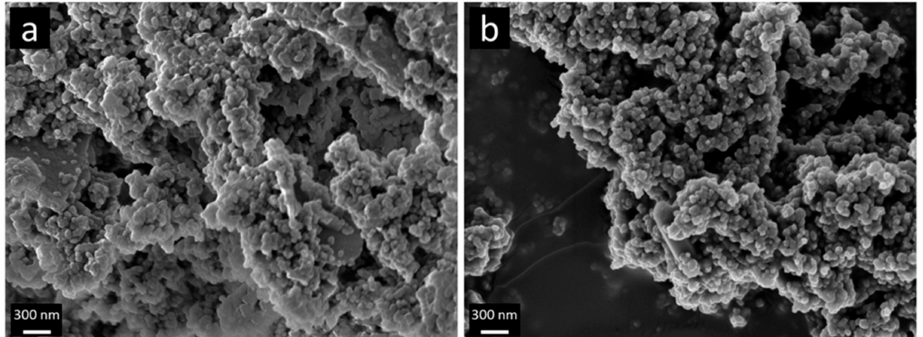
Figure 1. SEM images of samples ( a ) BPO and ( b ) BPO-C.